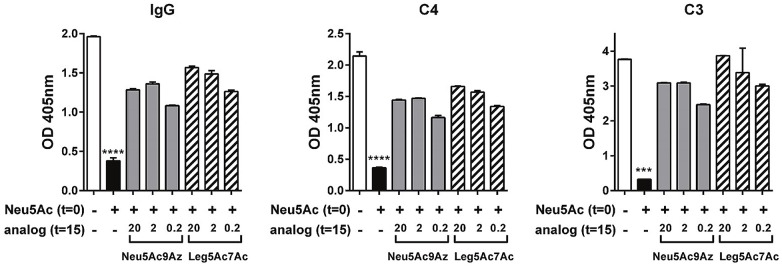
CMP-Neu5Ac9Az and CMP-Leg5Ac7Ac interfere with inhibition of the classical and alternative pathways of complement mediated by CMP-Neu5Ac.
N. gonorrhoeae (Ng) F62 ΔlgtD was incubated with CMP-Neu5Ac for 15 min followed by addition of CMP-Neu5Ac9Az or CMP-Leg5Ac7Ac (at concentrations of 20, 2 or 0.2 μg/ml) for 2 h as described in Fig 6. Bacteria were incubated in 10% normal human serum (NHS) and IgG binding and complement C3 and C4 fragment deposition was measured by ELISA as described in Fig 5. Mean (±SD) of two independent experiments is shown. Controls with heat-inactivated serum were carried out as described in Fig 5. MAb 2-8C-4-1 that detects the Neisserial lipoprotein H.8 was similar across all groups and confirmed similar capture of bacteria in all wells (OD405nm values ranged from 0.964 to 1.039). ***, P<0.001; ****, P<0.0001 compared to other bars in the same graph (ANOVA).